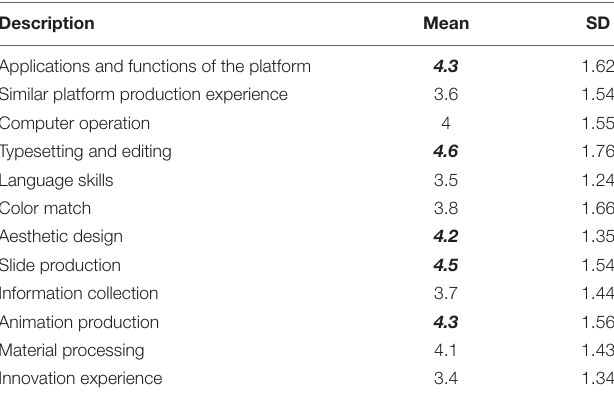
TABLE 3 | The objective knowledge of customers based on EQXIU innovation platform.